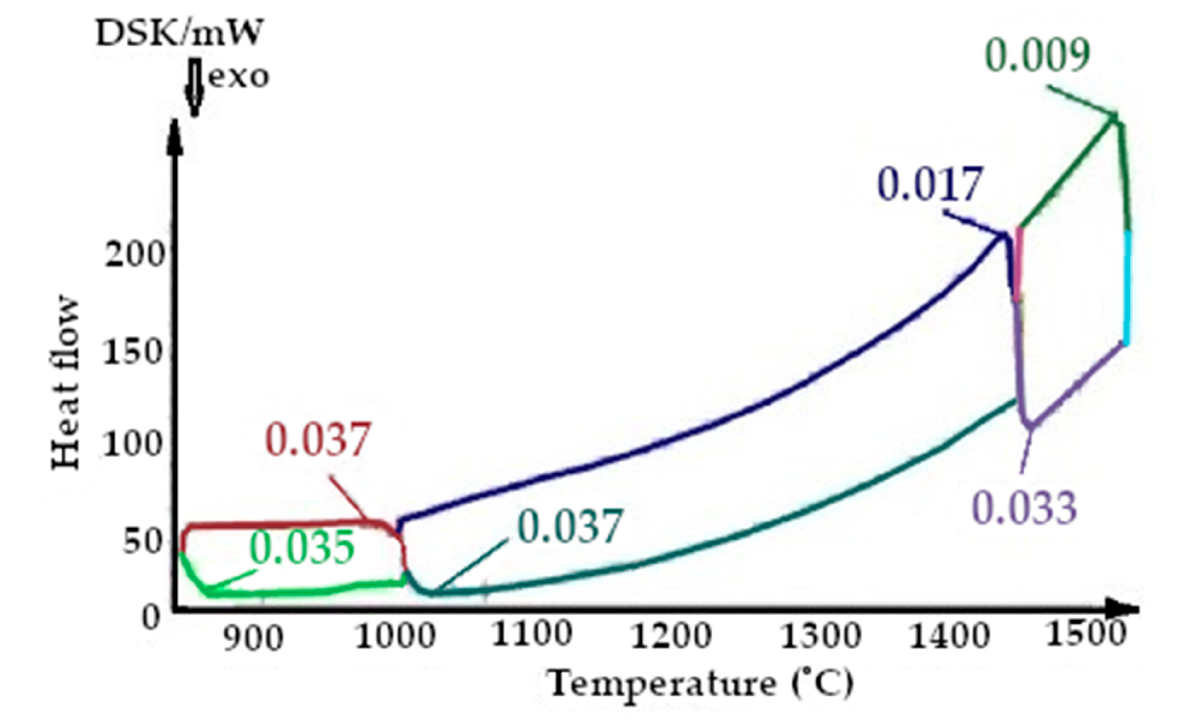
Figure 10. Fragment of the thermogram of quartzite, calcified at a temperature of 200 °C (Cycle 1), where: